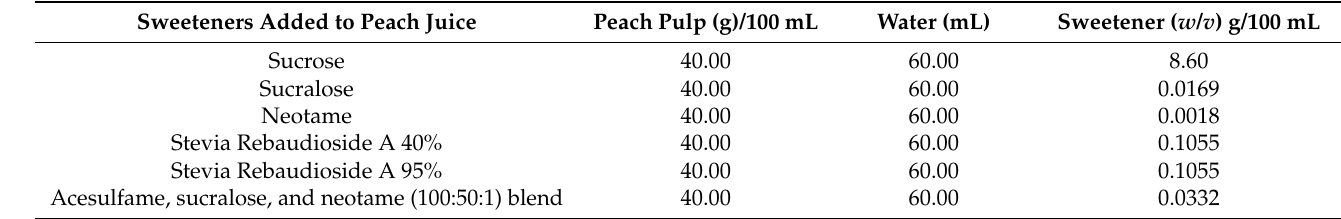
Table 1. Peach pulp *, water, and sweetener quantities to the six samples